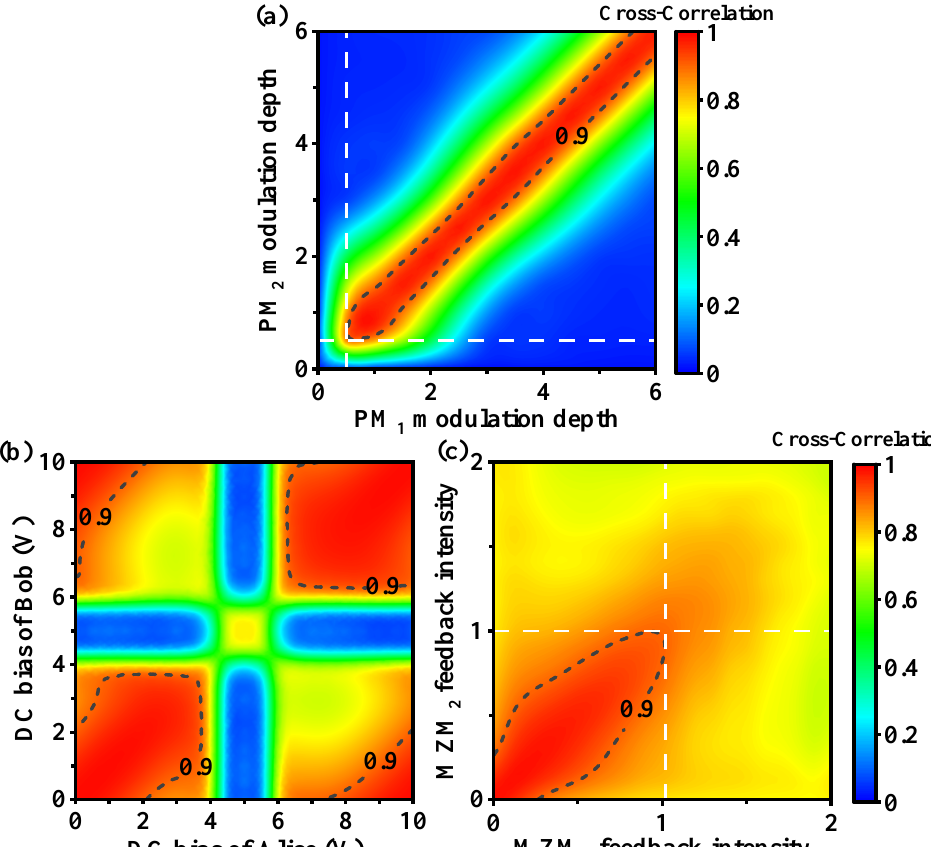
Figure 4. ( a ) Cross-correlation versus modulation depth of PM 1 and PM 2 ; ( b ) cross-correlation versus DC bias of Alice and Bob; ( c ) cross-correlation versus feedback intensity of MZM 1 and MZM 2